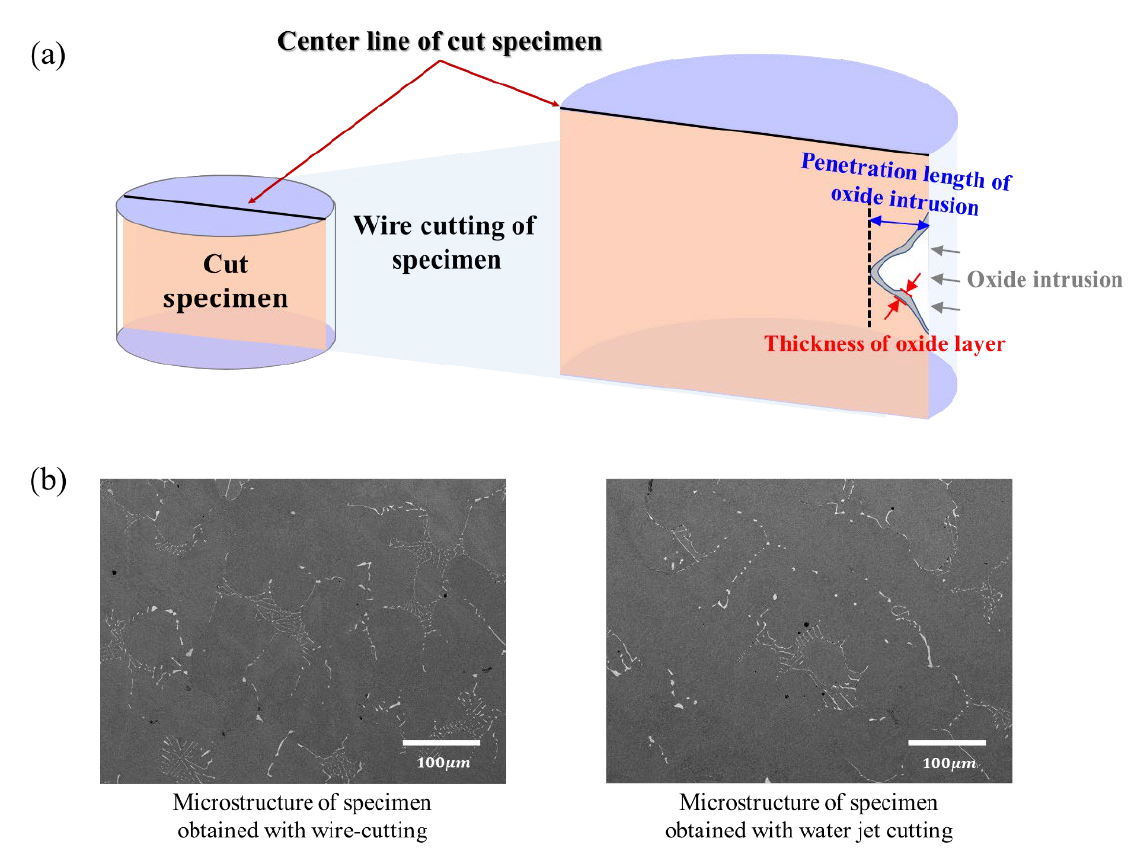
Figure 4. ( a ) Schematic of microstructural analysis: thickness of oxide layer and penetration length of oxide intrusion, and ( b ) results of microstructure analysis according to wire cutting and water jet cutting.